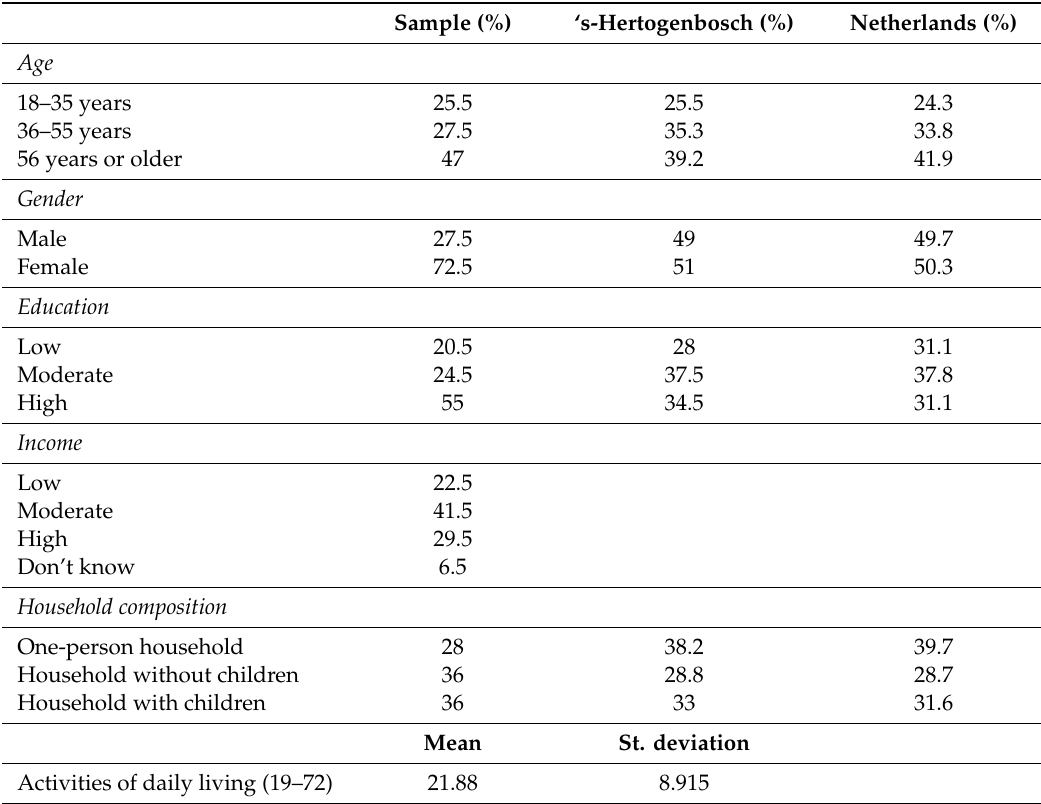
Table 2. Characteristics of participants (N =